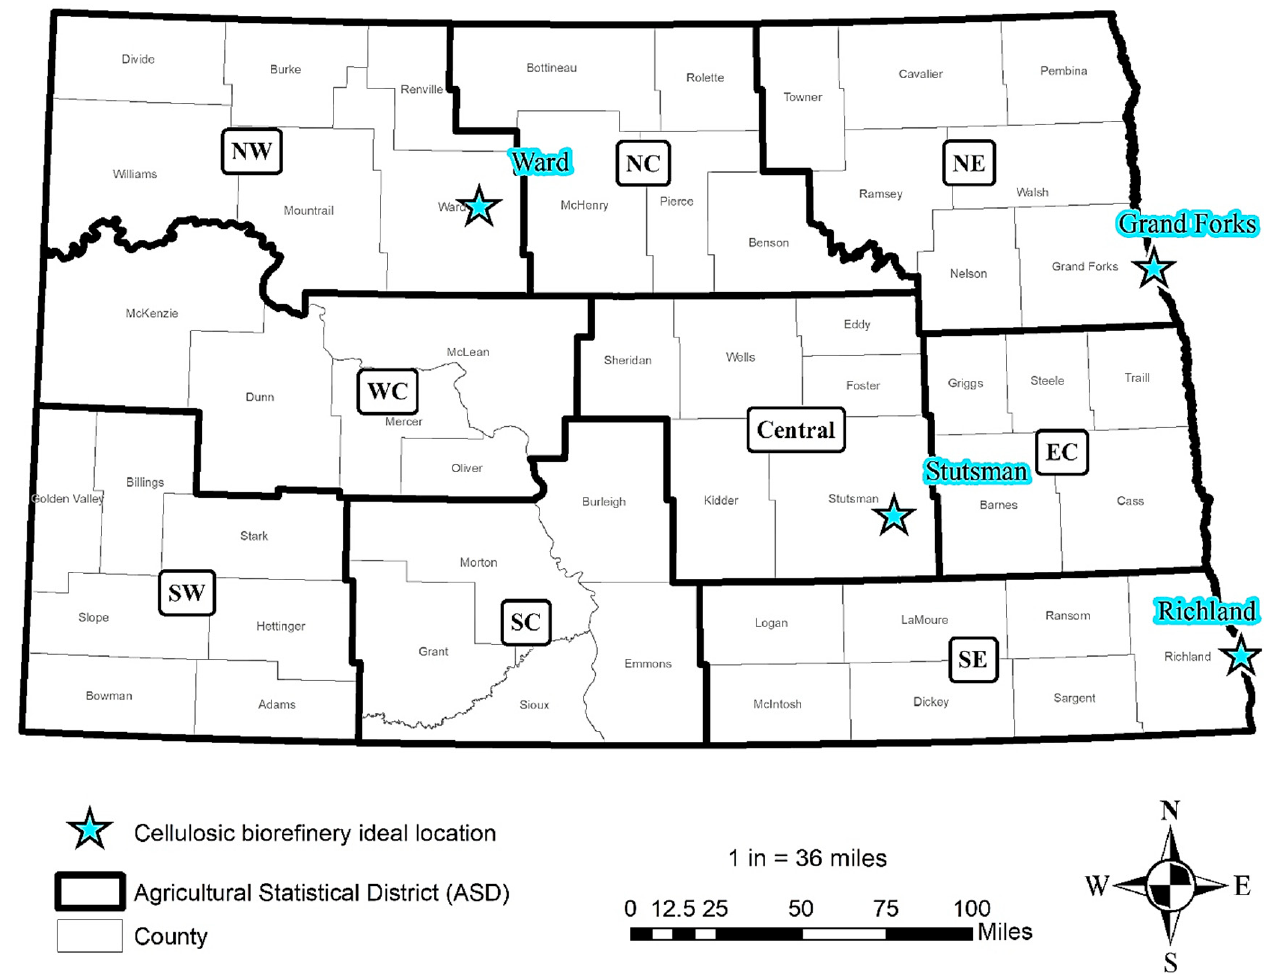
Figure 4. North Dakota map showing possible cellulosic biorefinery sites for switchgrass ‐ based bioethanol production.